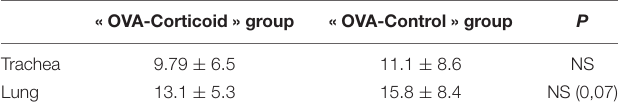
TABLE 3 | Tracheal and parenchymal eosinophil cell counts expressed as number of cells per field (mean ± standard deviation) in both groups (“OVA-Corticoids” group and “OVA-Control” group).